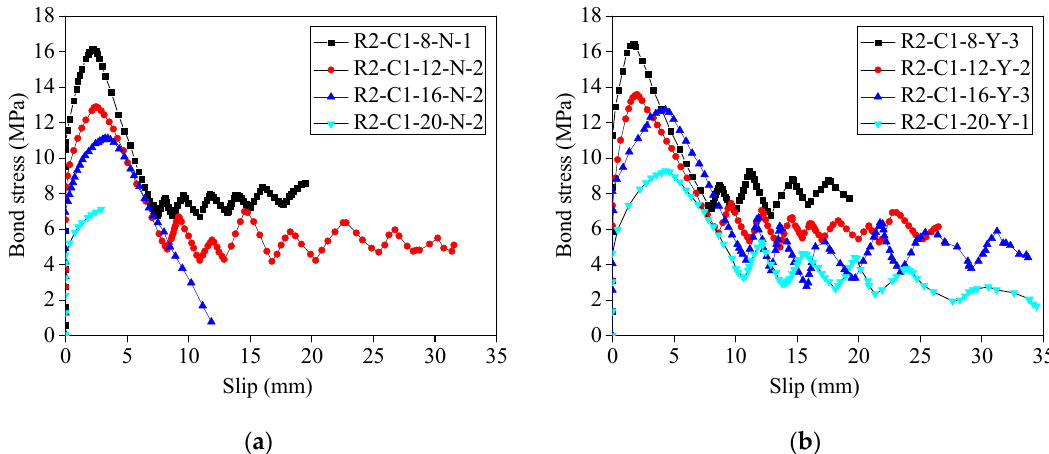
Figure 8. Representative τ - s curves for R4 bars for the ( a ) without and ( b ) with stirrups.